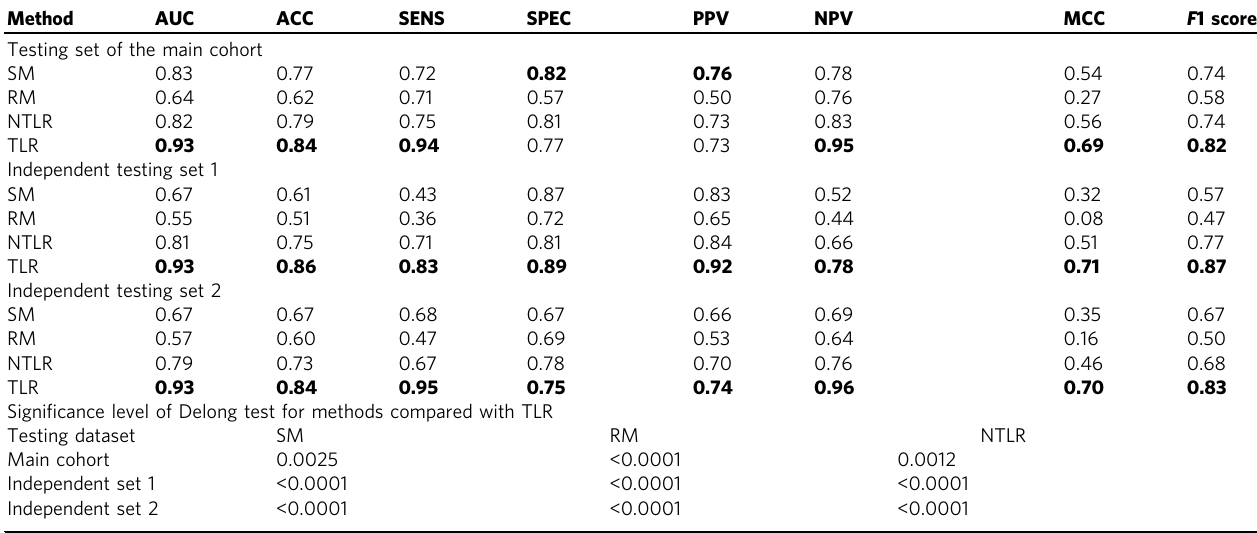
The bold values represent the best value of an index in the comparative